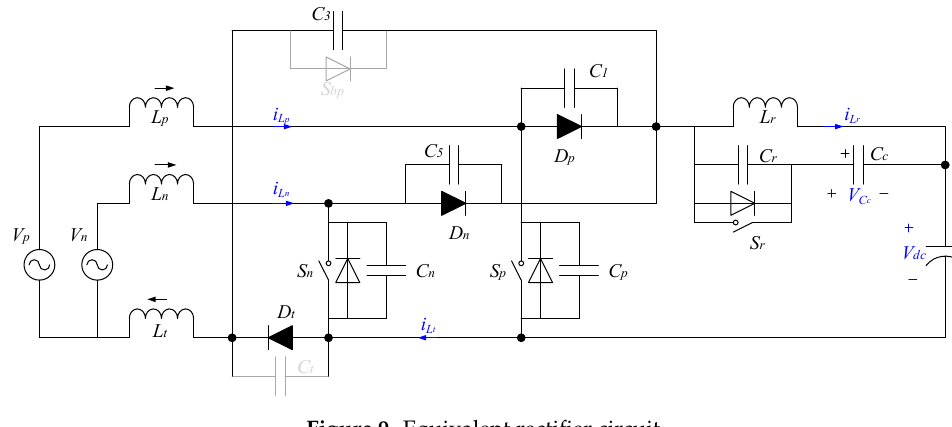
Figure 9. Equivalent rectifier circuit.